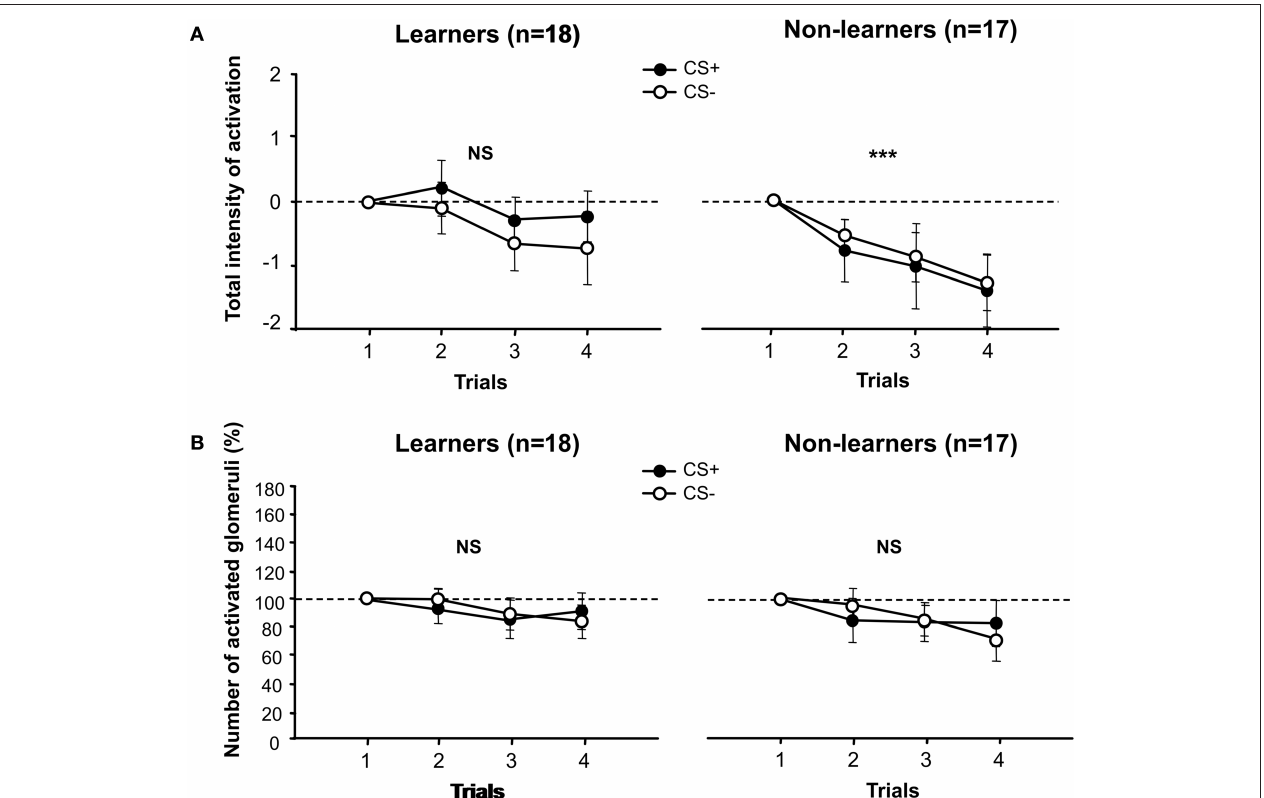
different odors activate different numbers of glomeruli in naïve bees, we normalized the data to the number of glomeruli activated by each odor in the first trial (100%). Left : for learners no difference was found between the number of glomeruli activated by the CS + and the CS − during conditioning trials ( stimulus effect, p = NS). Right : for non-learners, there was also no difference between the number of glomeruli activated by the CS + and the CS − during conditioning trials ( stimulus effect, p = NS). Aversive conditioning does not modify global activity of the antennal lobe in a